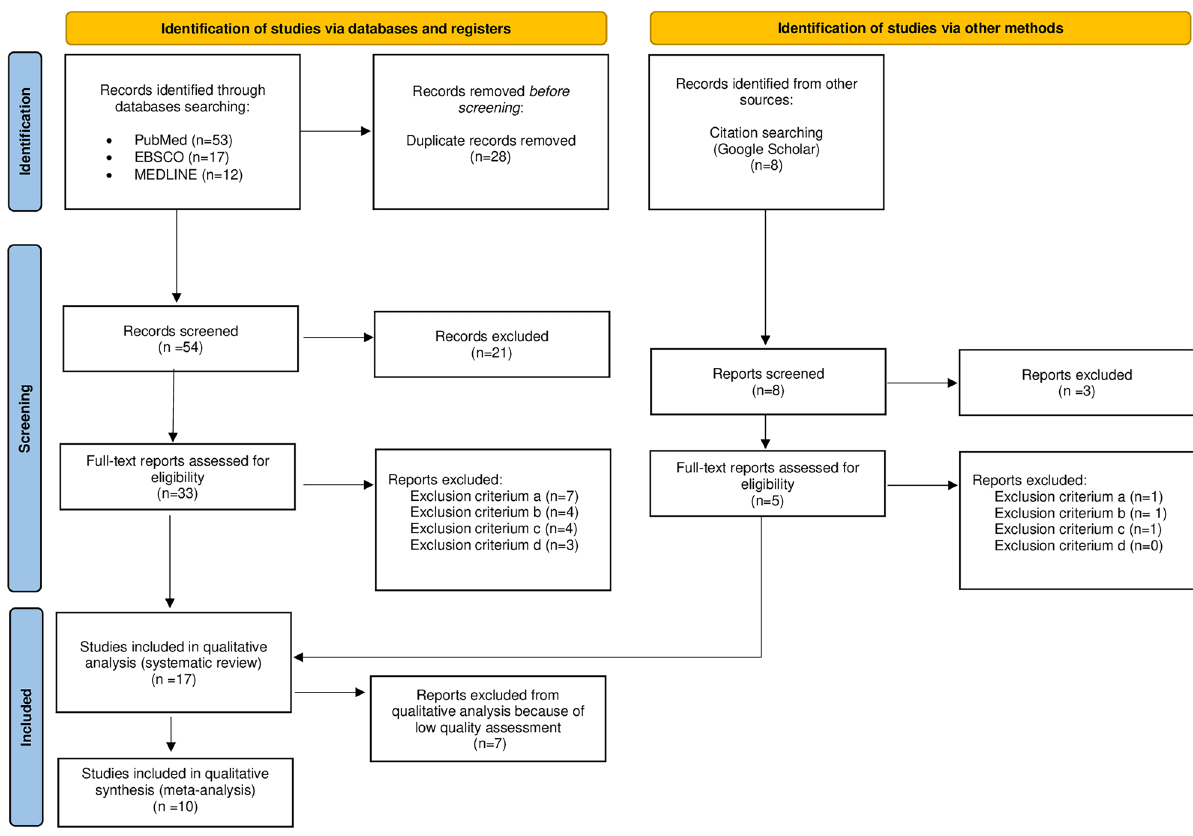
Figure 1. PRISMA flow diagram detailing the study inclusion process 23